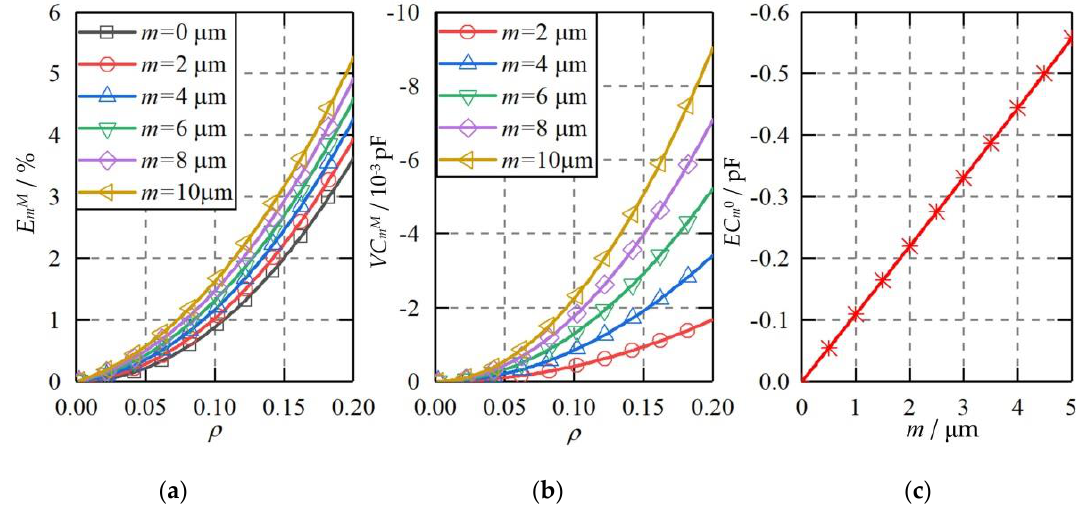
Figure 12. The theoretical capacitance error when the plate is axial offset from the ideal position. ( a ) Higher-order capacitance error, ( b ) variable capacitance error, ( c ) constant capacitance error.